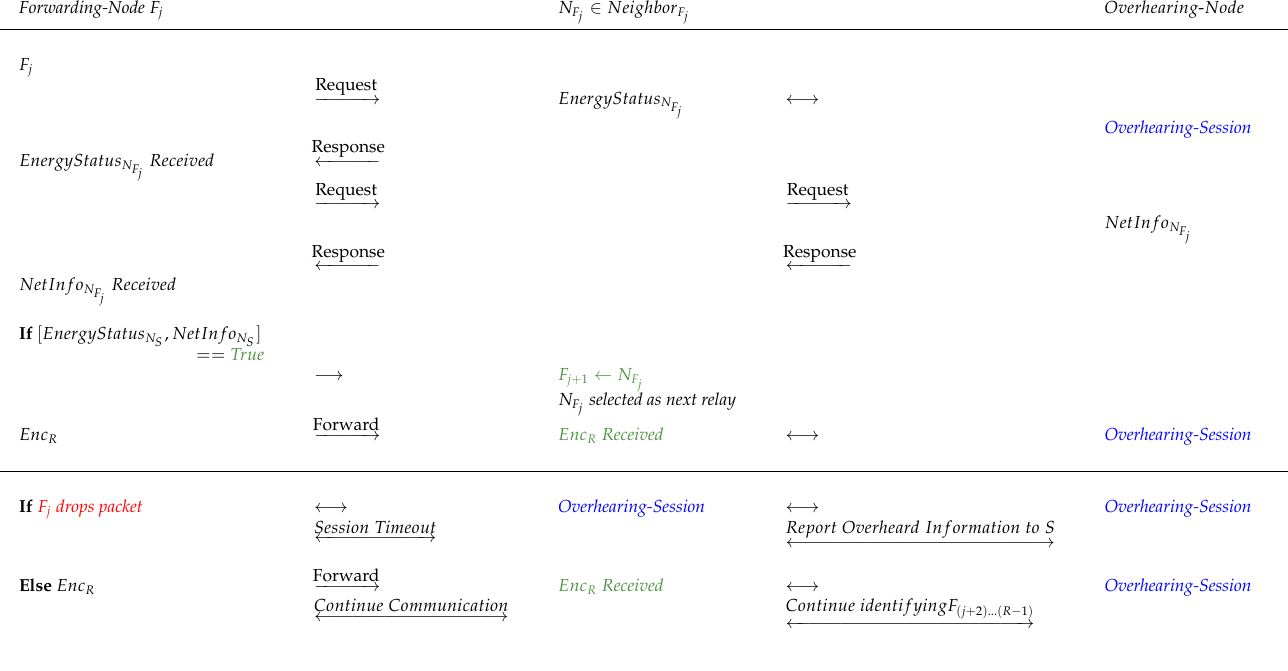
Figure 5. Selfish node—blackhole